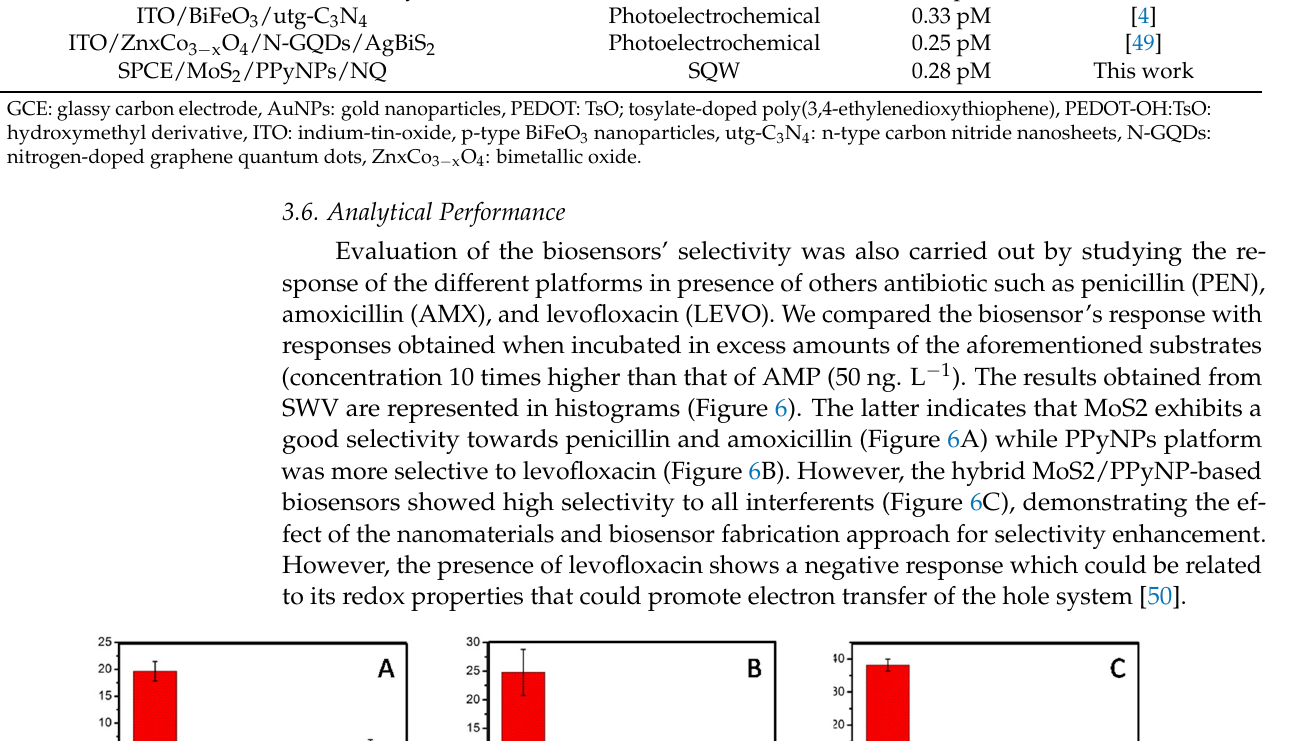
Table 1. Properties of various biosensors developed for ampicillin.